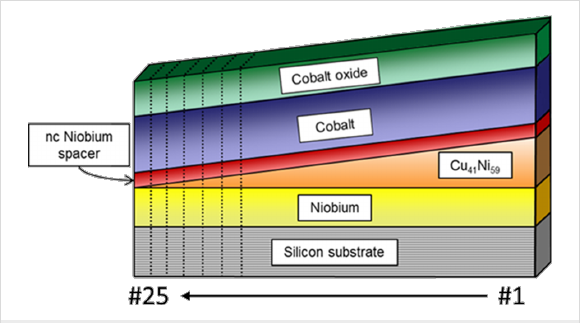
Figure 1: Sketch of the prepared Nb/Cu 41 Ni 59 /nc-Nb/Co/CoO x sam- ple system SF 1 NF 2 -AF1. The dotted lines indicate the cutting proce- dures yielding the individual